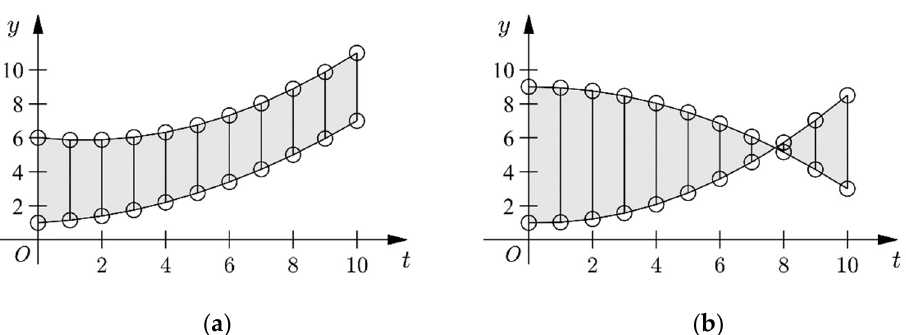
Figure 7. The area between the two center lines. ( a ) The area of two center lines when they have no intersection between [0, τ ], ( b ) the area of two center lines when they have an intersection between [0, τ ].